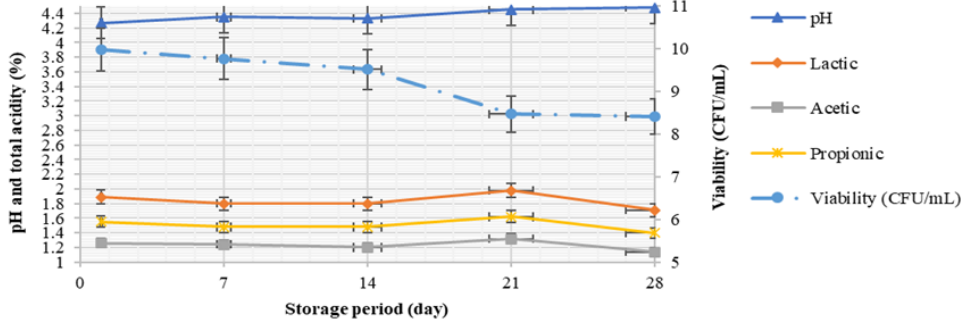
Figure 3. Viability of fermented soymilk during shelf life (storage period) for 28 days at 4 degrees . Standard error bars resented standard error.